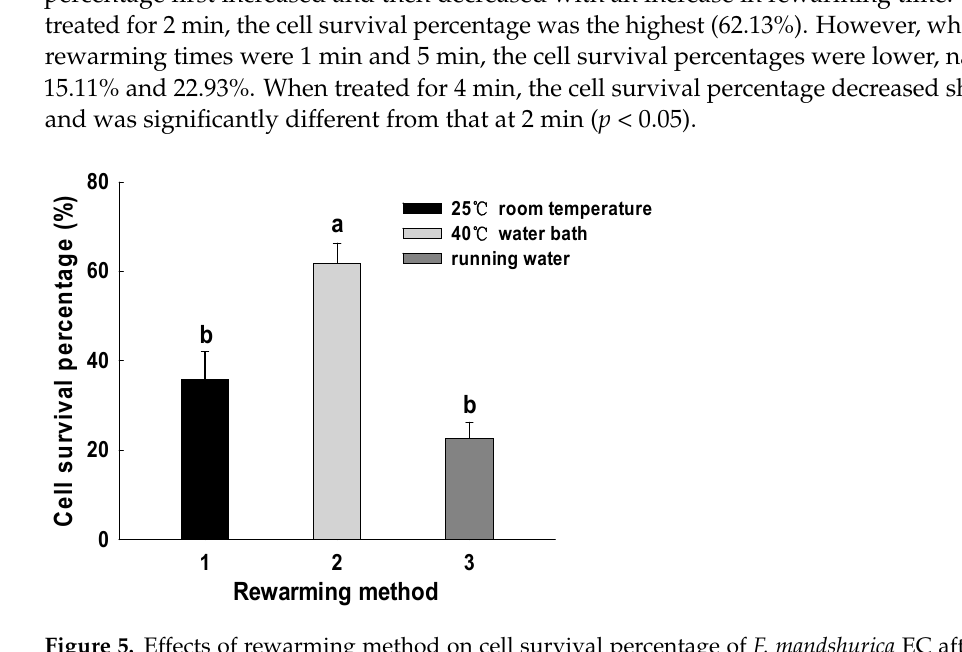
Figure 5. Effects of rewarming method on cell survival percentage of F. mandshurica EC after cryopreservation by vitrification. Note: Different letters are significantly different from each other at p < 0.05, using Duncan’s Multiple Range Test. Table 6. Effect of rewarming time on fresh weight of F. mandshurica EC after cryopreservation by vitrification.